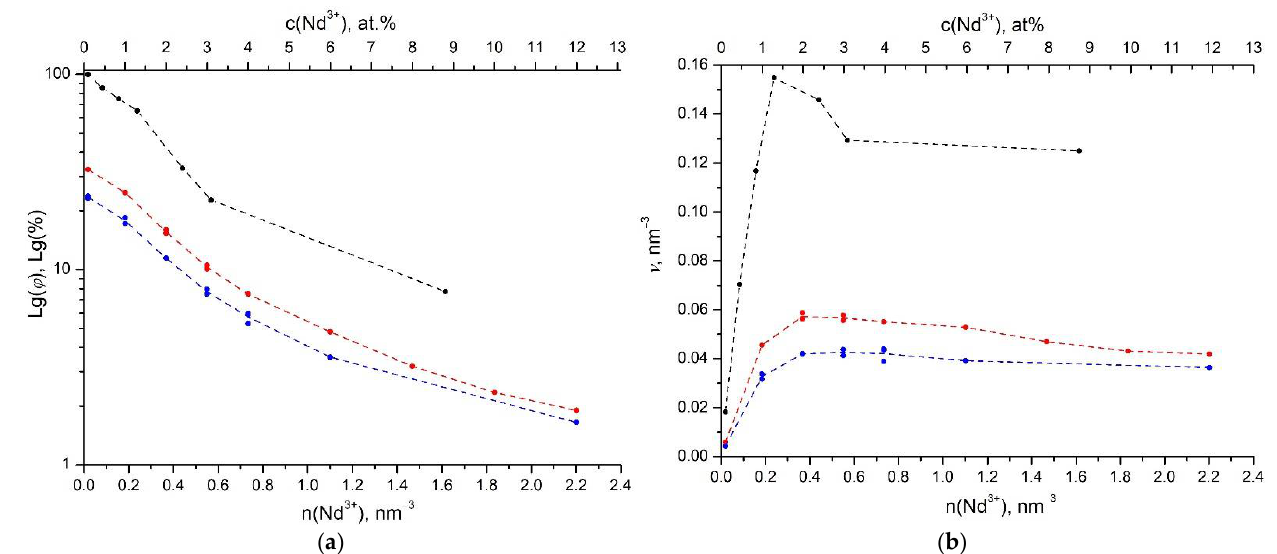
Figure 10. Concentration dependence of the relative quantum yield ϕ ( a ) and fluorescence brightness ν ( b ) of the 4 F 3/2 level of the Nd 3+ ion in single crystals (black circles) and aqueous colloidal solutions of Nd 3+ : LaF 3 NPs samples of type I (blue circles) and type II (red circles) (for NPs samples of type I τ R = 1400 µ s and NPs of type II τ R = 1300 µ s ). Dashed blue and red curves are drawn through the arithmetic mean values of the corresponding parameters. For single crystals, the dashed black curve is drawn through the measured values of ϕ and ν